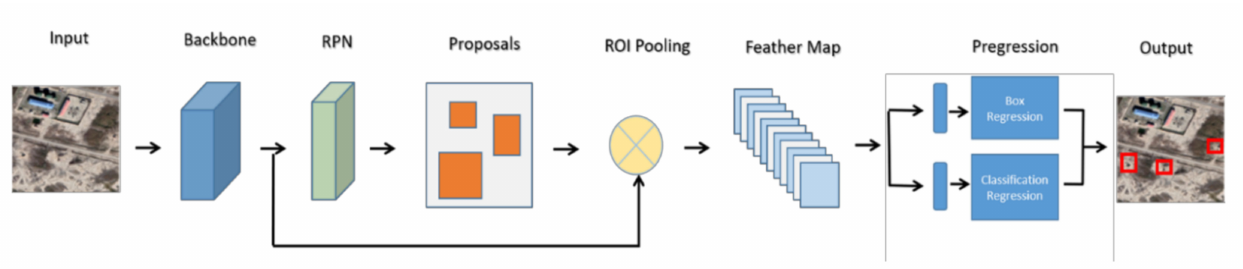
Figure 8. Faster R-CNN